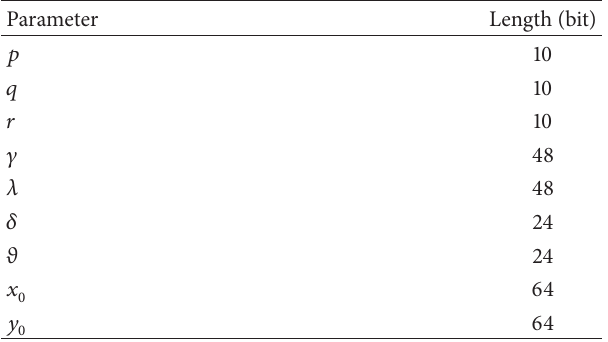
Table 4: Secret parameters length in bit. Table 5: Comparison of encryption time for proposed algorithm with recent similar